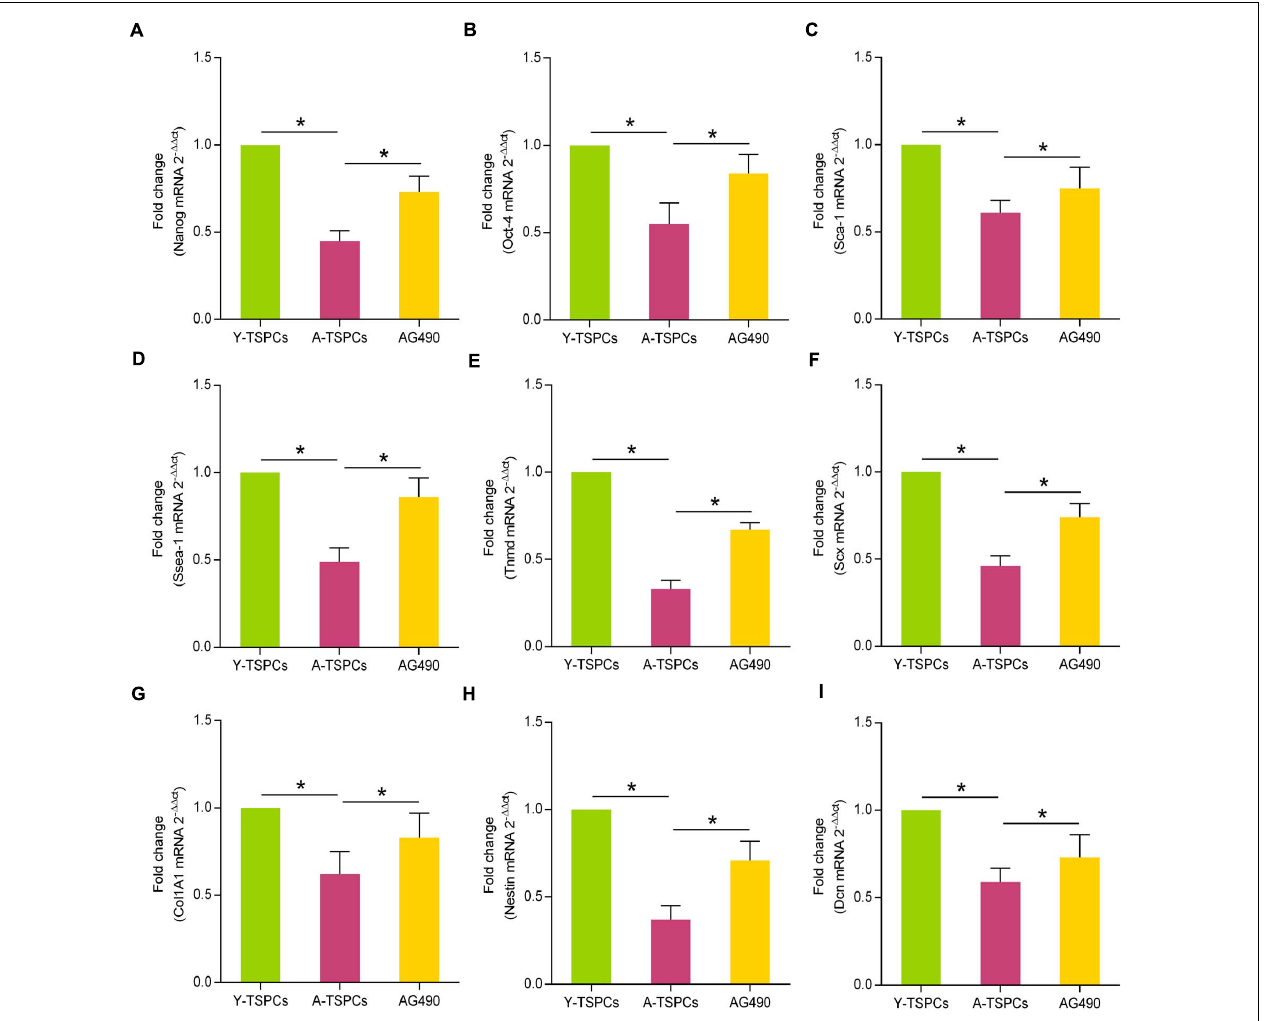
FIGURE 7 | AG490 increases the expressions of stem cell markers and tendon-related genes in aged TSPCs. (A – D) Relative mRNA levels of stem cell markers (Nanog, Oct-4, Sca-1, and Ssea-1) in young, aged, and aged AG490-treated TSPCs were investigated by qRT-PCR. (E – I) qRT-PCR for the tendon-related genes (Tnmd, Scx, Col1A1, Nestin, and Dcn) upon AG490 treatment. * P < 0.05 compared with the young or aged group.